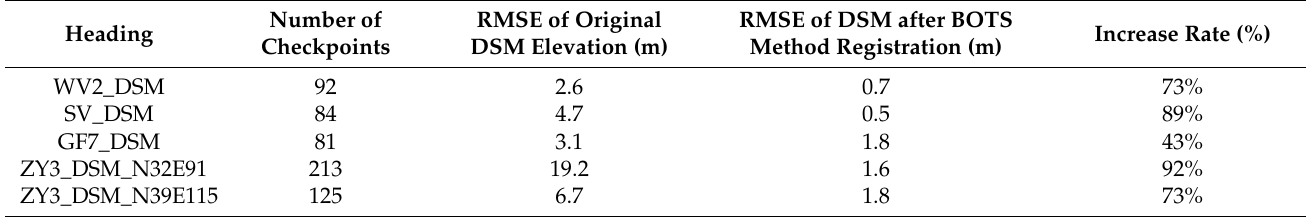
Table 2. DSM accuracy after fusion of ICESat-2